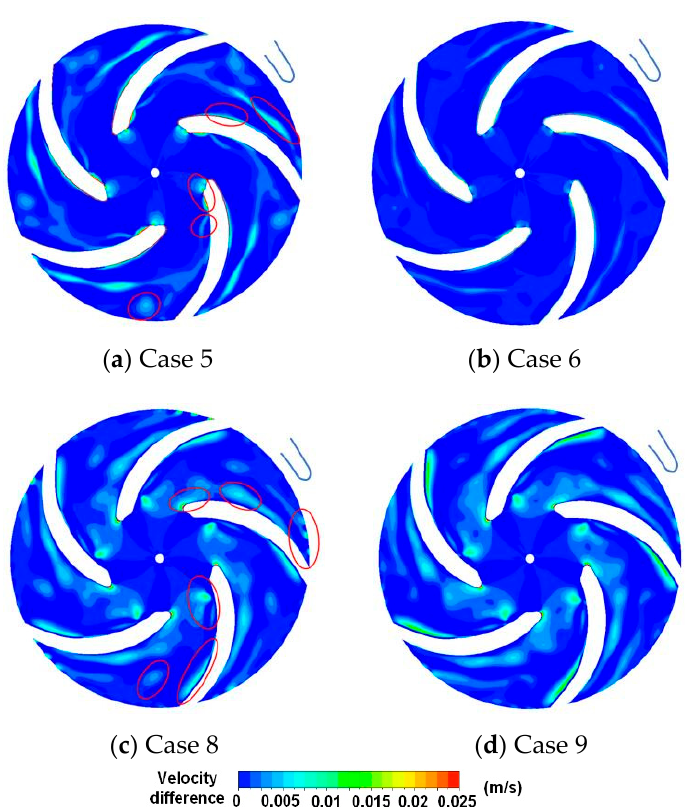
Figure 11. Distribution of total velocity variation on the center plane in the decreasing flow rate section.